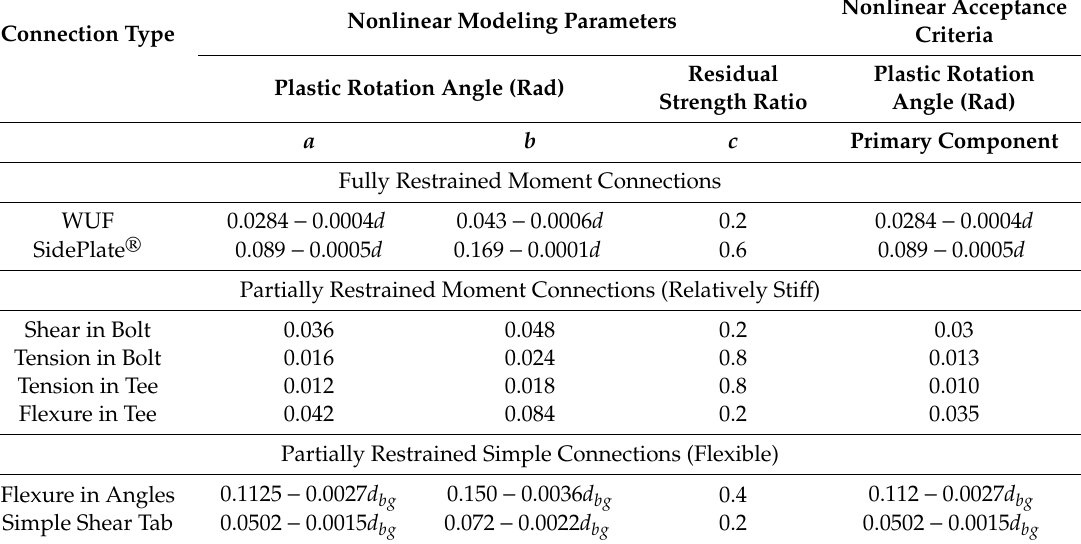
Table 4. Modeling Parameters and Acceptance Criteria for Nonlinear Modeling of Steel Frame Connections.